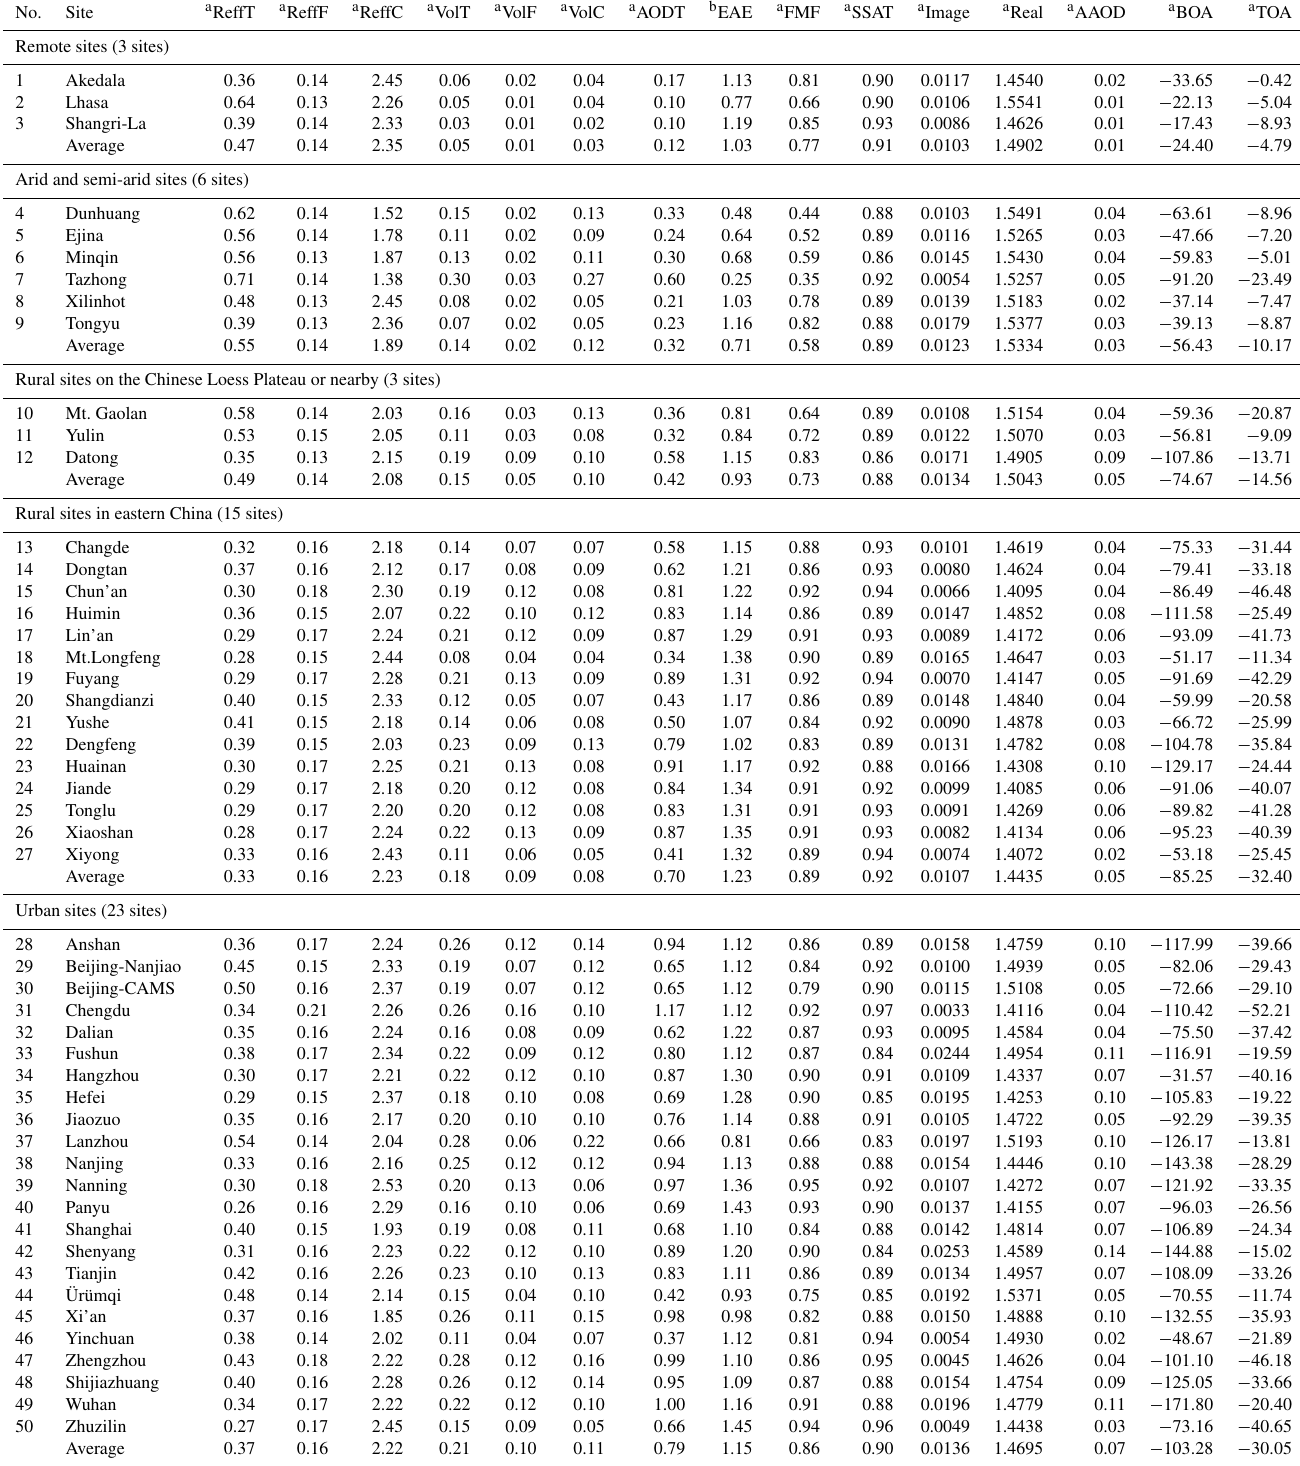
Table A2. Annual data for aerosol microphysical properties and optical and direct radiative parameters. No.